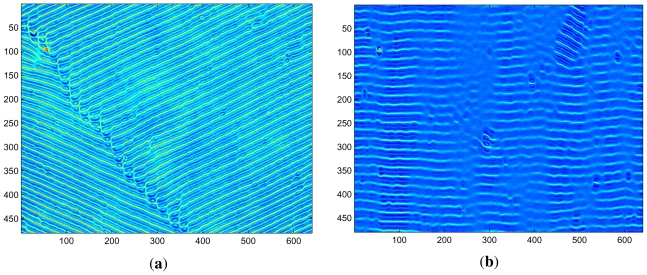
Snapshots of patterns in cell A at 35 °C for (a) f0 =90 Hz (ω0τq =0.27), V =10.38V (ε = 0.05), and (b) f0 =95 Hz (ω0τq =0.29), V =10.39V (ε = 0.016).